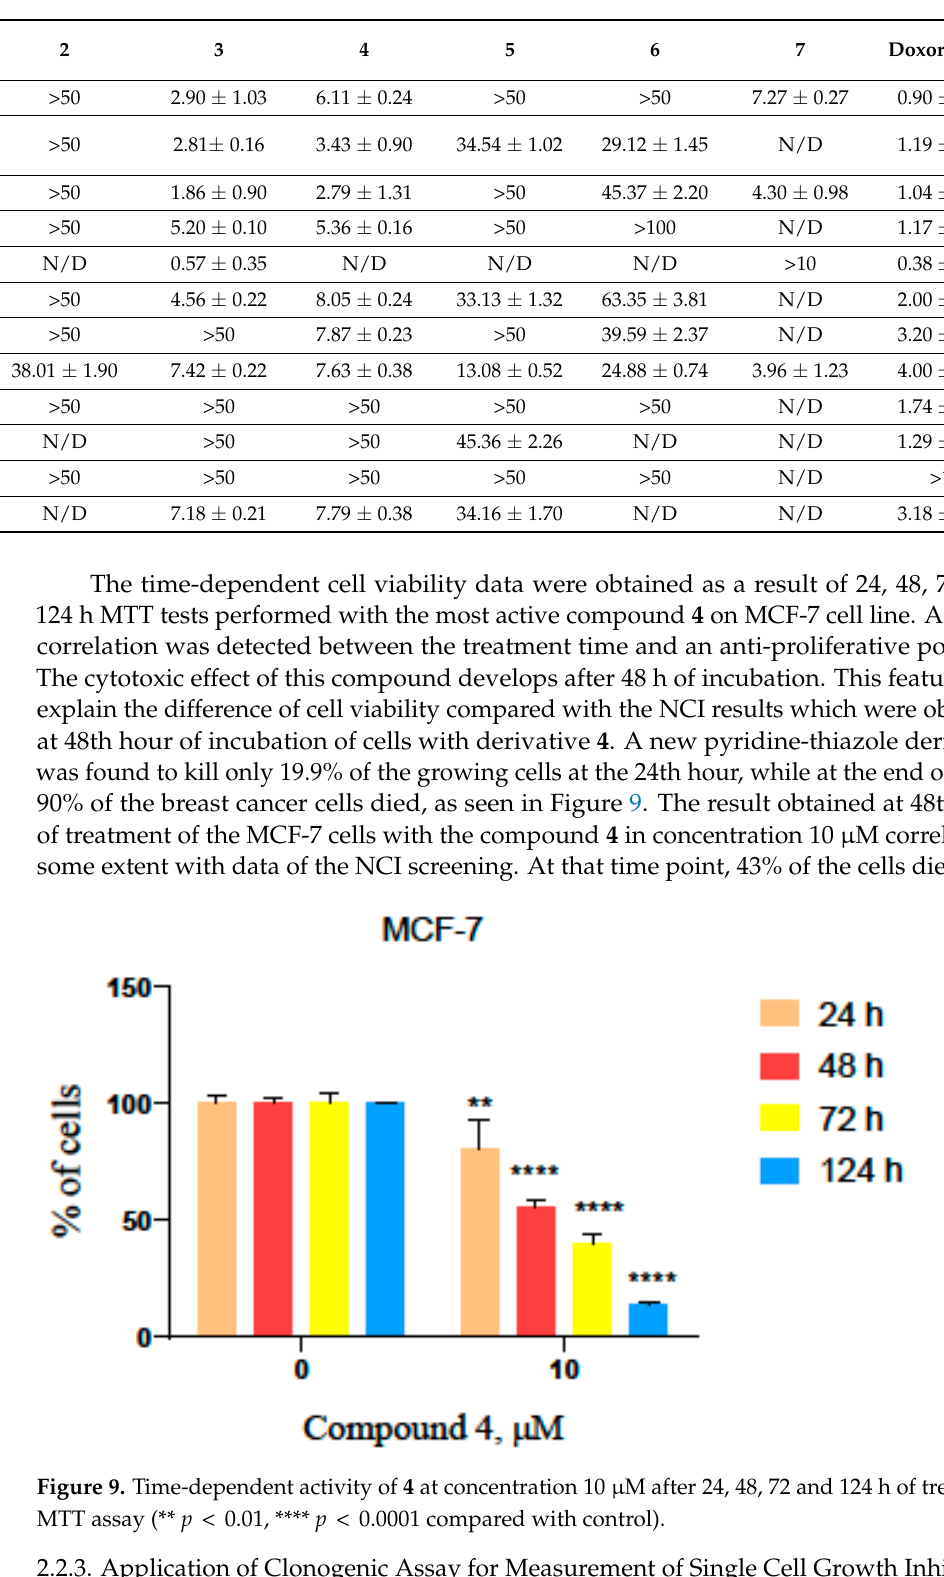
Table 5. The IC 50 values of screened compounds towards a panel of tumor and pseudo-normal cell lines. N/D—not determined (72 h of incubation, µ M, M ± SD).